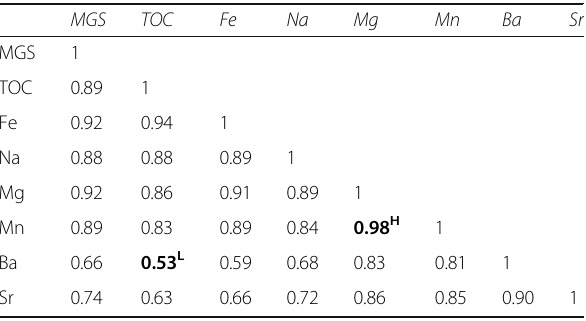
Table 3 Correlation coefficient between MGS, TOC, and selected metals in core KR2 MGS